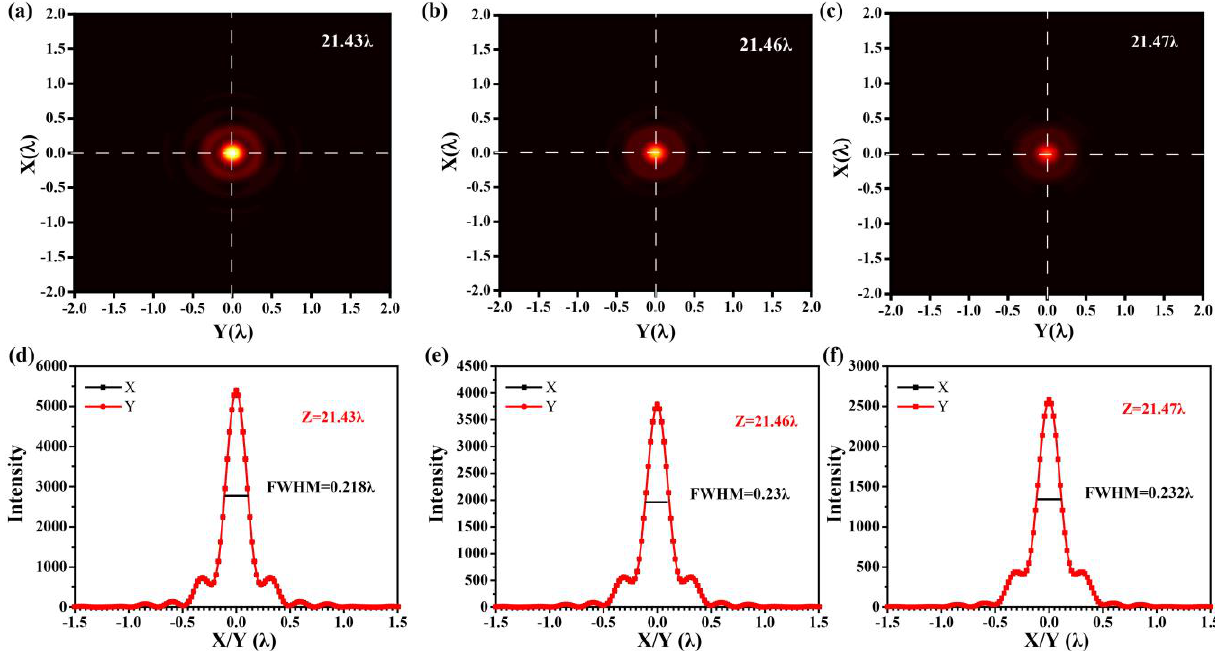
Figure 4. The intensity obtained by FDTD in the focal plane at z = 21.43 λ ( a ), 21.46 λ ( b ), and 21.47 λ ( c ), respectively. The intensity curves obtained by FDTD at z = 21.43 λ ( d ), 21.46 λ ( e ), and 21.47 λ ( f ) on the x – axis and y – axis.